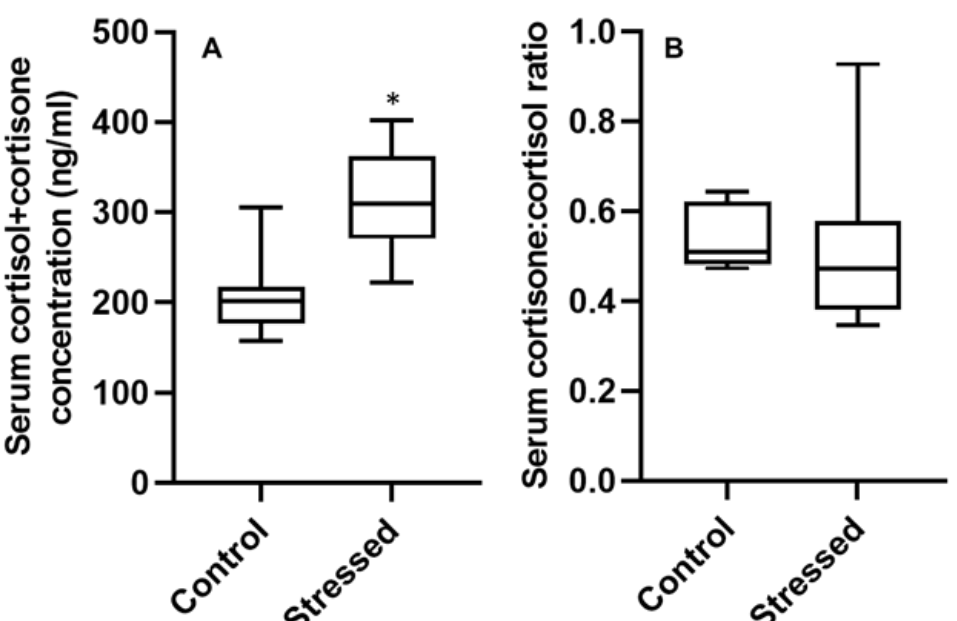
Figure 5. Multi-hormone values calculated from goldfish serum hormone concentrations: ( A ) serum cortisol + cortisone concentration and ( B ) serum cortisone:cortisol ratio in control and stressed goldfish presented as the median (middle line), surrounded by the 95% confidence interval (rectangle) with whiskers extending to the full range of the data. Asterisk indicates a significant difference from control ( p < 0.05; n = 14).